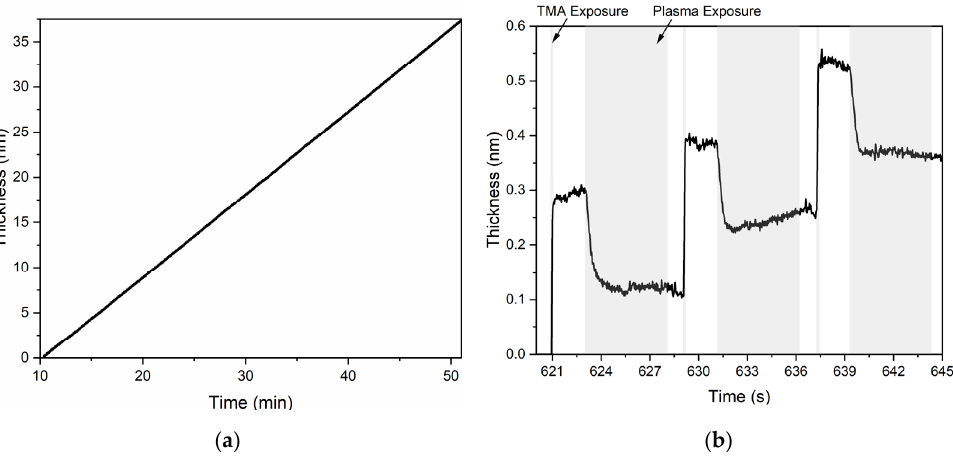
Figure 3. Thickness measured in real time for Al 2 O 3 PEALD at 250 °C: ( a ) showing a linear growth over many cycles; ( b ) over the first three cycles, the shaded areas show the time periods during which the TMA and O 2 -plasma were exposed.